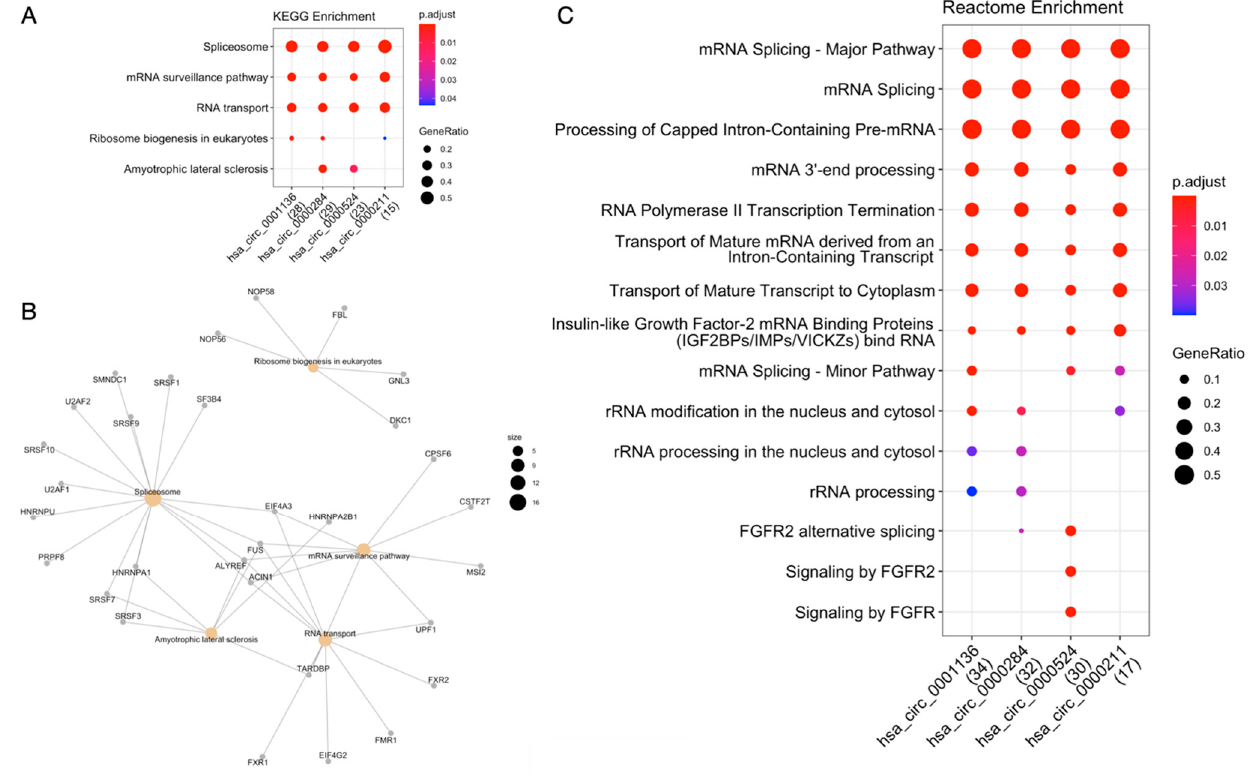
Figure 3. Functional enrichment analysis of circRNA-RBP interactions. ( A ) KEGG enrichment analysis. ( B ) Network of RBPs and enriched KEGG pathways. ( C ) Reactome enrichment analysis.